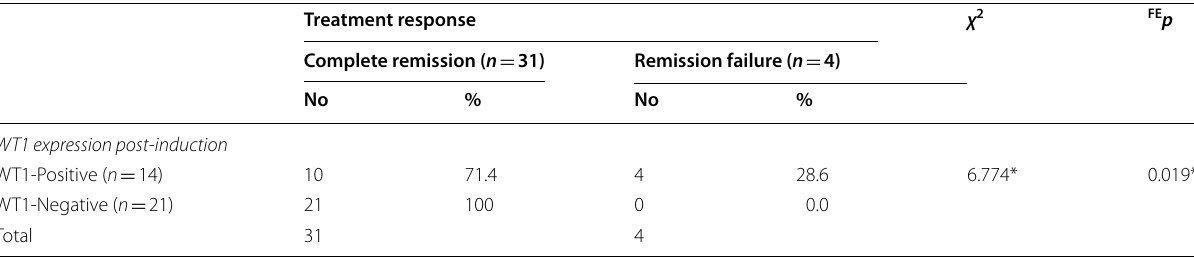
Table 5 Relation between hematological response and WT1 expression post-induction chemotherapy ( n